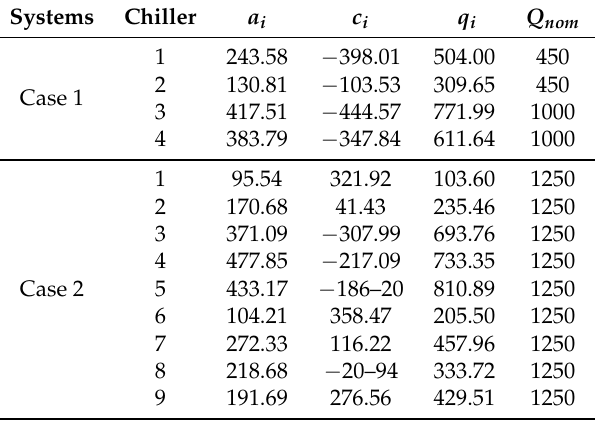
Table A2. Estimated parameters of chillers’ P-PLR